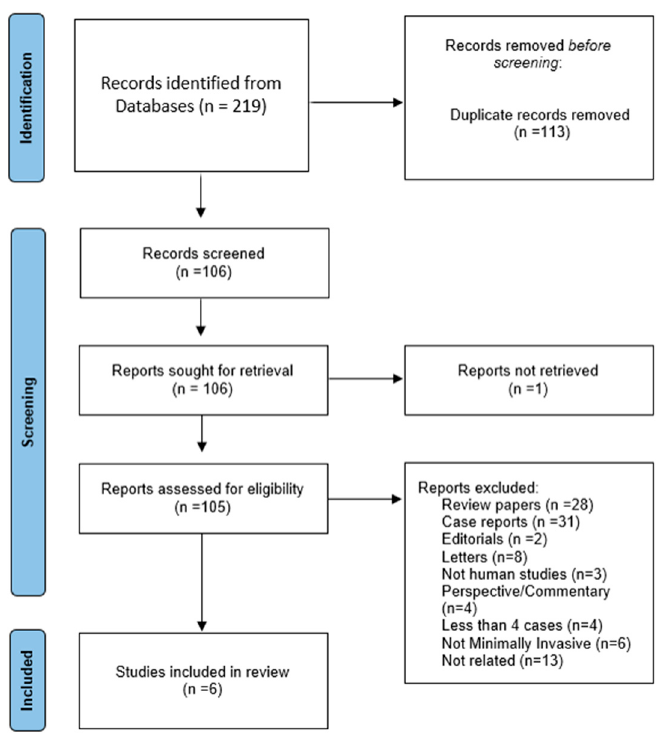
Figure 3. Search strategy and reason for exclusion of studies.